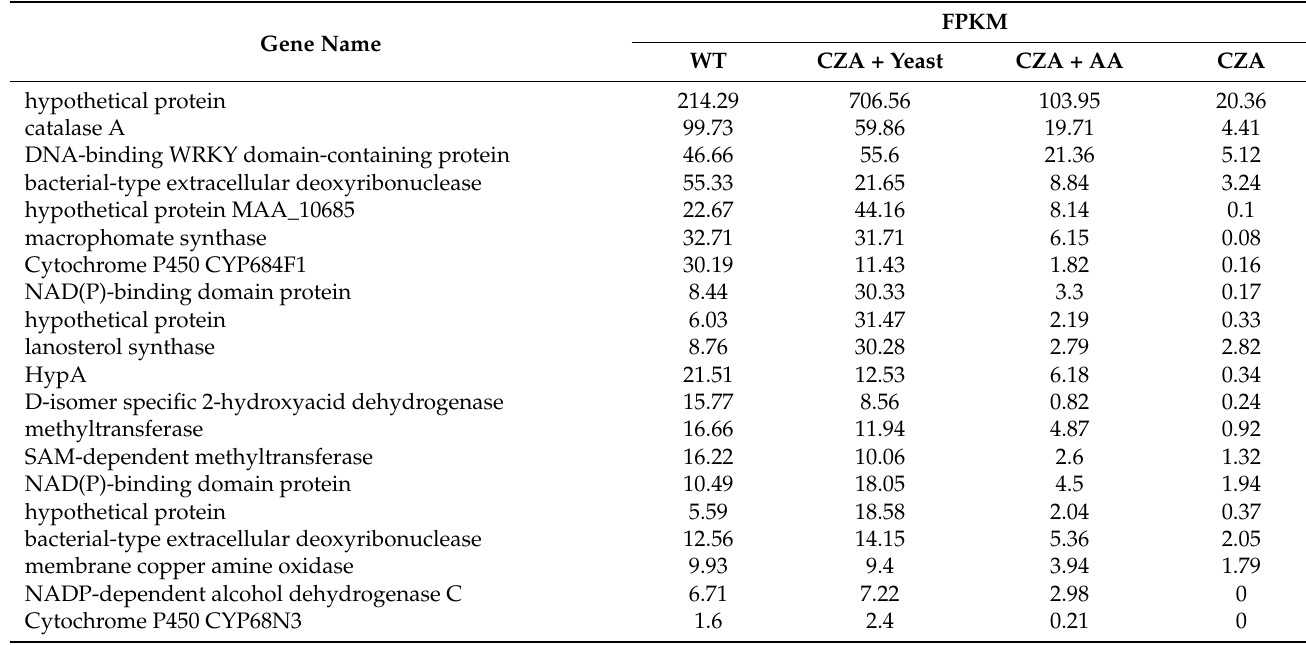
Figure 6. Venn diagrams of DEGs between conidial germinated and non-germinated samples ( A ) and mycelial growth and non-growth samples ( B ). DEGs in common were analyzed with KEGG enrichment. WT: The WT strain cultured on CZA plates; CZA: ∆ MrilvC mutant grown on CZA plates; CZA + AA: ∆ MrilvC mutant grown on CZA + AA plates; CZA + yeast: ∆ MrilvC mutant grown on CZA + yeast plates. Table 2. Potential genes involved in conidial